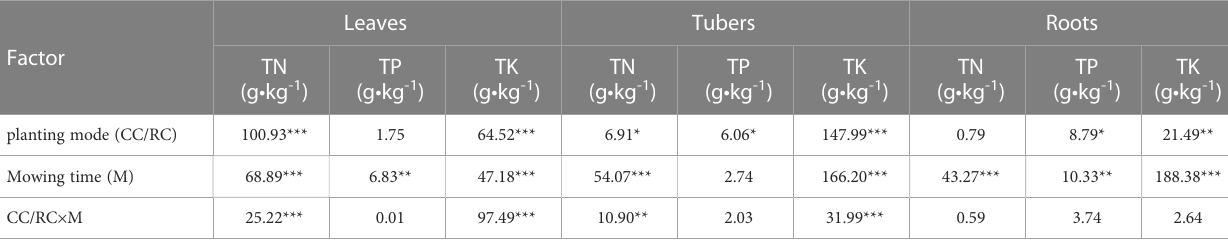
TABLE 5 Two-way ANOVA analysis of effects of the planting mode and mowing time on the physicochemical property of the leaves, tubers, and roots of C. esculentus . Leaves Tubers Roots Factor